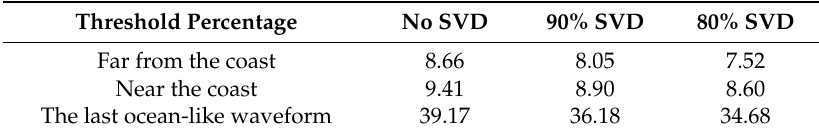
Table 10. 20-Hz epoch noise (cm) for different singular value decomposition (SVD) configurations (cycle